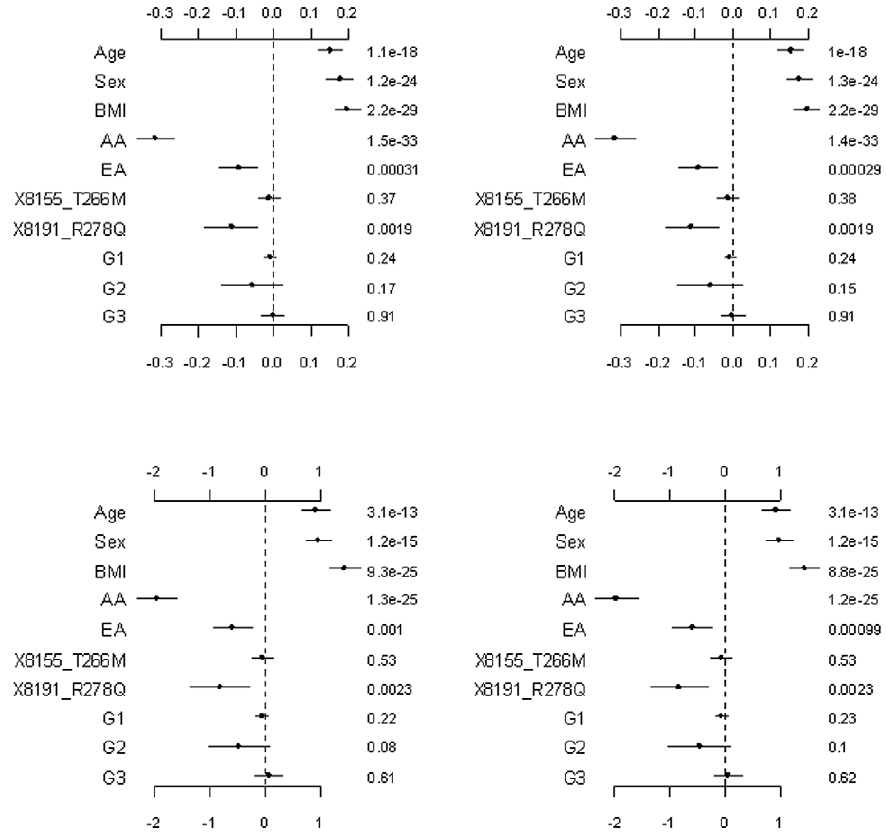
Figure 5. Setting the weights of individual variants to fixed values m j . The top and bottom panels are for the continuous and binary traits, and the left and right panels are for Simple-Sum and Weighted-Sum methods, respectively. The points, short lines and numbers at the right side represent estimates of effects, 6 2 standard errors, and p -values, respectively.